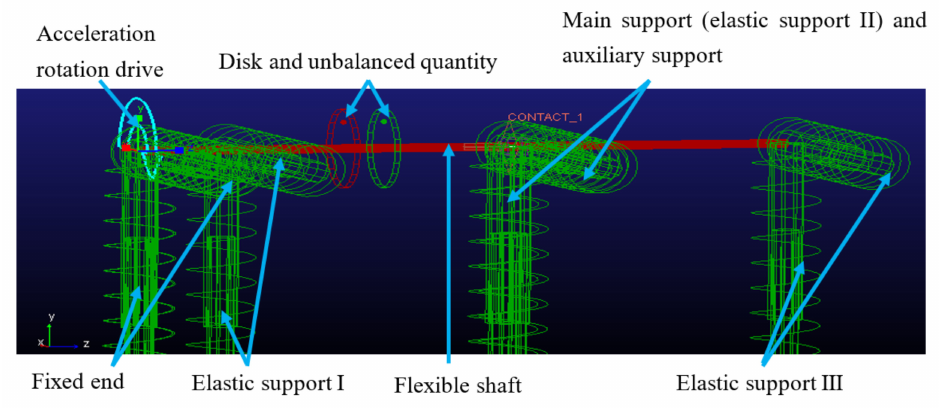
Figure 4. Virtual prototype model of double-disk